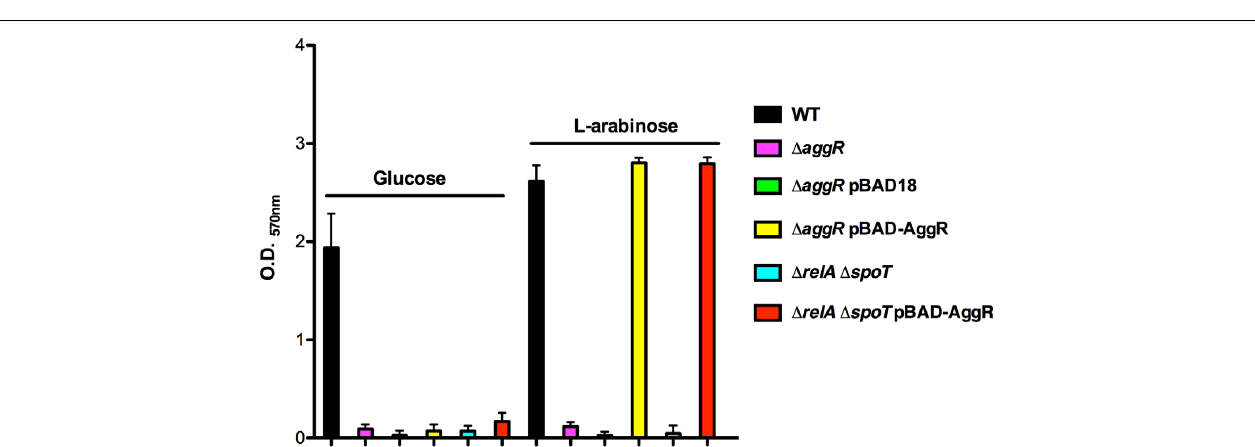
FIGURE 6 | Biofilm formation in strain 042 requires both the AggR protein and physiological levels of (p)ppGpp. Quantification of biofilm formed by strain 042 and its aggR and relAspoT derivatives, in the presence and in the absence of plasmid pBAD-AggR. Cells were cultured in LB medium supplemented either with glucose or L -arabinose at 0.45%. The data shown are the means and standard deviations of three independent